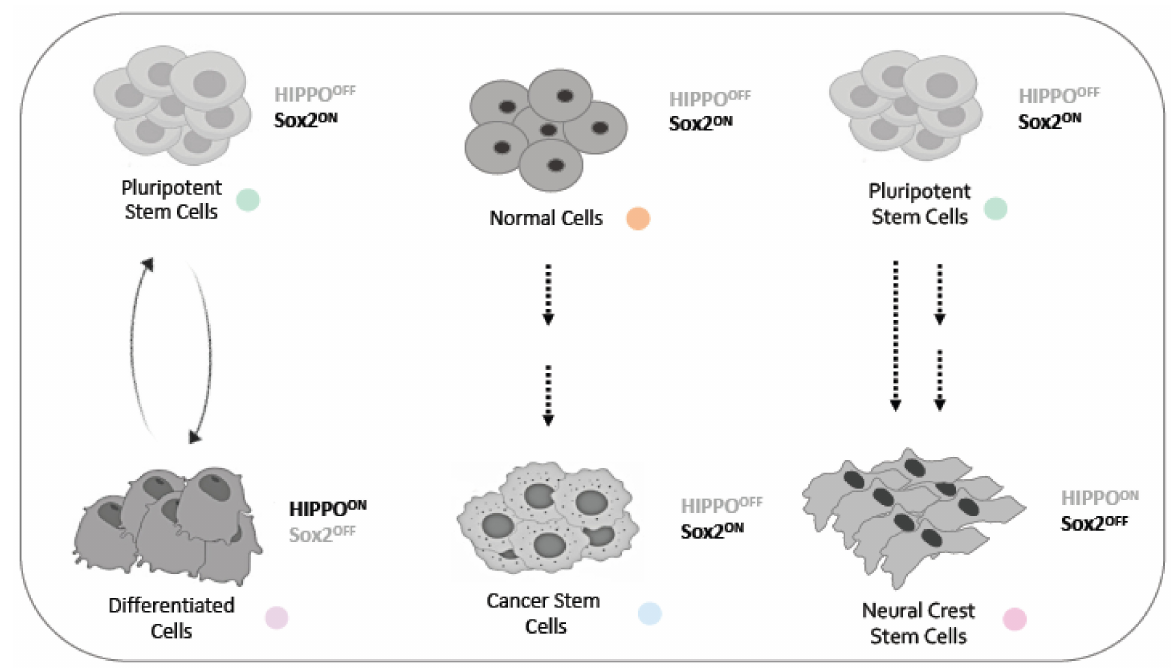
Figure 2. A model for the Hippo pathway and Sox2 crosstalk in healthy and diseased cells. In embryonic stem cells (ESCs), the nucleation of Yap enhances the binding of Nanog, Sox2 and Oct4 at YAP-binding loci [42]. Yap -/- ESCs retain their undifferentiated Sox2 + Oct4 + embryonic stem cell characteristics, while Yap overexpression forces ESC to exit the cell cycle, driving lineage-specific differentiation. Thus, Yap1 levels orchestrate the balance between pluripotency and multipotency in ESCs [43], while reprogramming to induced Pluripotent stem Cells (iPSCs) can be achieved by Oct3/4, Sox2 and Yap overexpression [44,45] (Figure